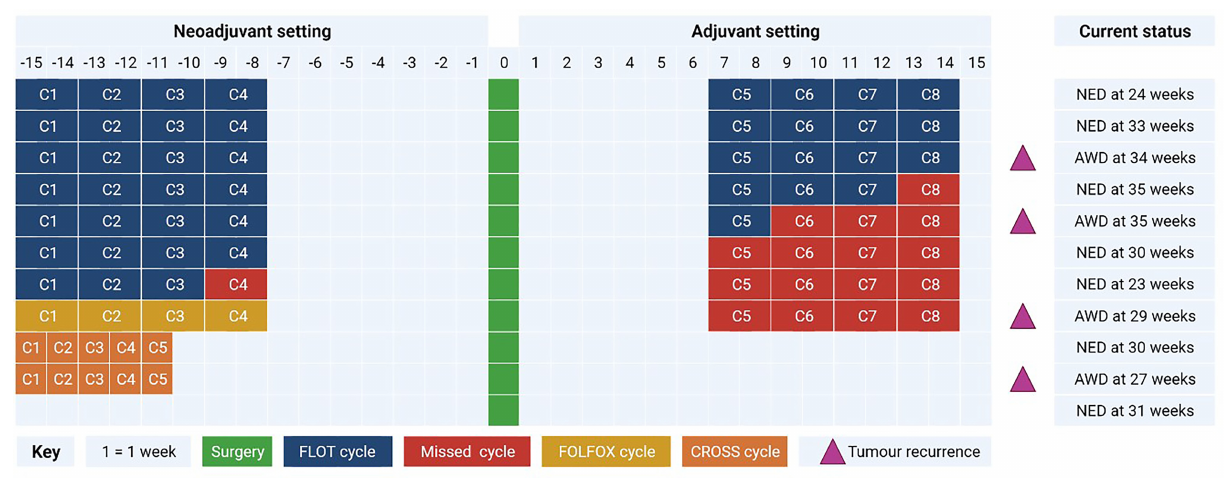
NED, No evidence of disease; AWD, Alive with